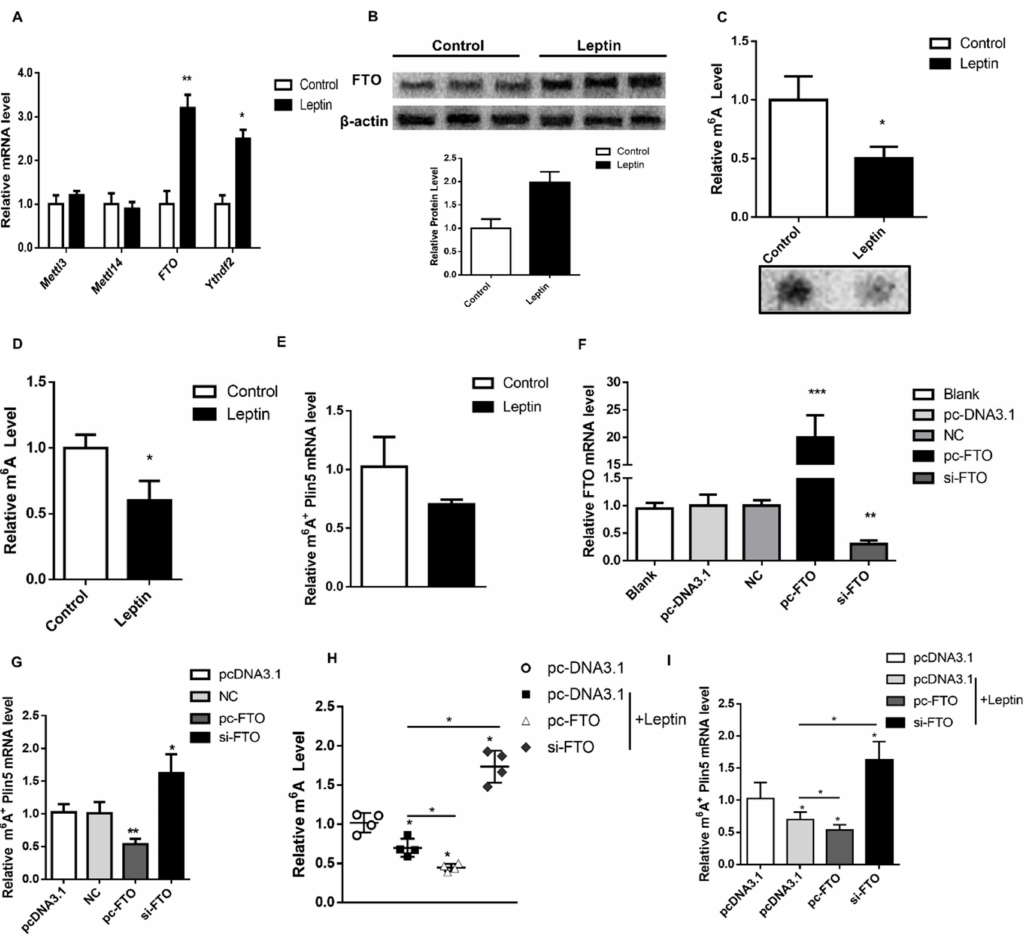
Figure 3. Leptin inhibits the m 6 A methylation of Plin5 through FTO. ( A ) Porcine adipocytes in vitro were treated with 50 nmol/ µ L leptin for 24 h to detect the mRNA expression of methylation-related genes. ( B ) The protein expression of